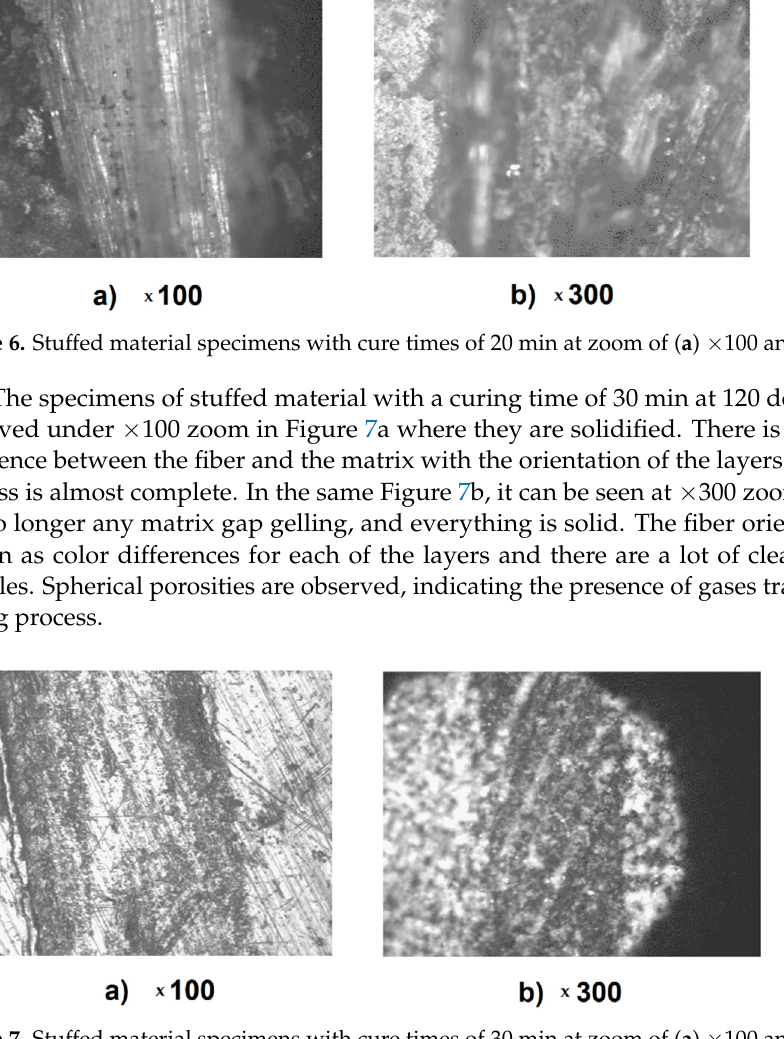
Figure 7. Stuffed material specimens with cure times of 30 min at zoom of ( a ) ×100 and ( b )